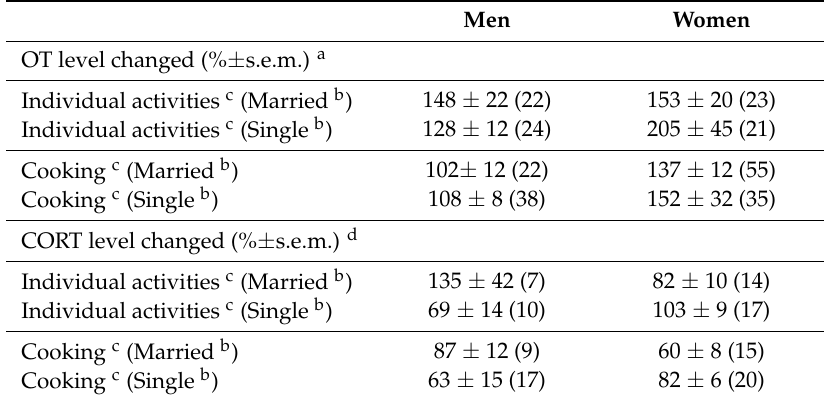
Figure 2. Percentage changes in oxytocin levels before and after a single session. Percentage of oxytocin levels for the first (before) saliva over the second (after) saliva samples after each session. Saliva was collected during individual (non-cooking) and group (cooking) activities in men ( A ) and women ( C ). The average percentage of oxytocin levels for the first (before) saliva over the second (after) saliva samples in individual male ( B ) and female ( D ) participants. p -values are for two-tailed Student’s t -tests: ( A ) p = 0.0216 between individual activity (n = 44) and cooking (n = 55) in men; ( B ) p = 0.0492, between individual activity (n = 9) and cooking (n = 9) in men; ( C ) p = 0.1849 between individual activity (n = 44) and cooking (n = 90) in women; ( D ) p = 0.6373 between individual activity (n = 9) and cooking (n = 9) in women. Filled and open symbols represent married and single participants, respectively. Table 3. Percentage of OT and CORT levels for the first (before) saliva over the second (after) saliva samples after each session in married and single participants.